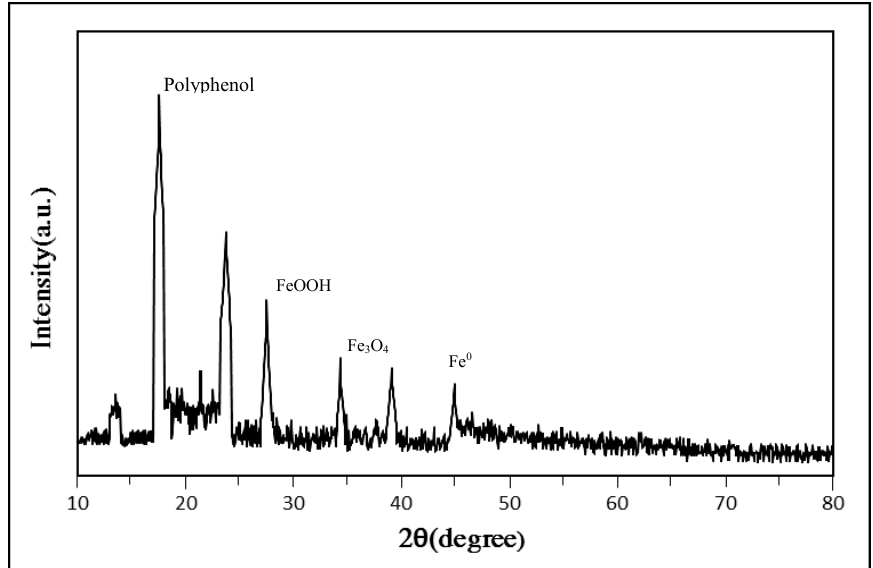
Figure 3. X-ray diffraction (XRD) pattern of synthesized iron nanoparticles from the mixture of Figure 3. X-ray di ff raction (XRD) pattern of synthesized iron nanoparticles from the mixture of extracts.